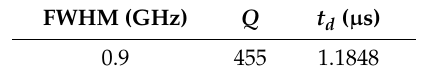
Table 3. Filter quality and performance parameters considering a distance between wires d = 17.5 μ m.